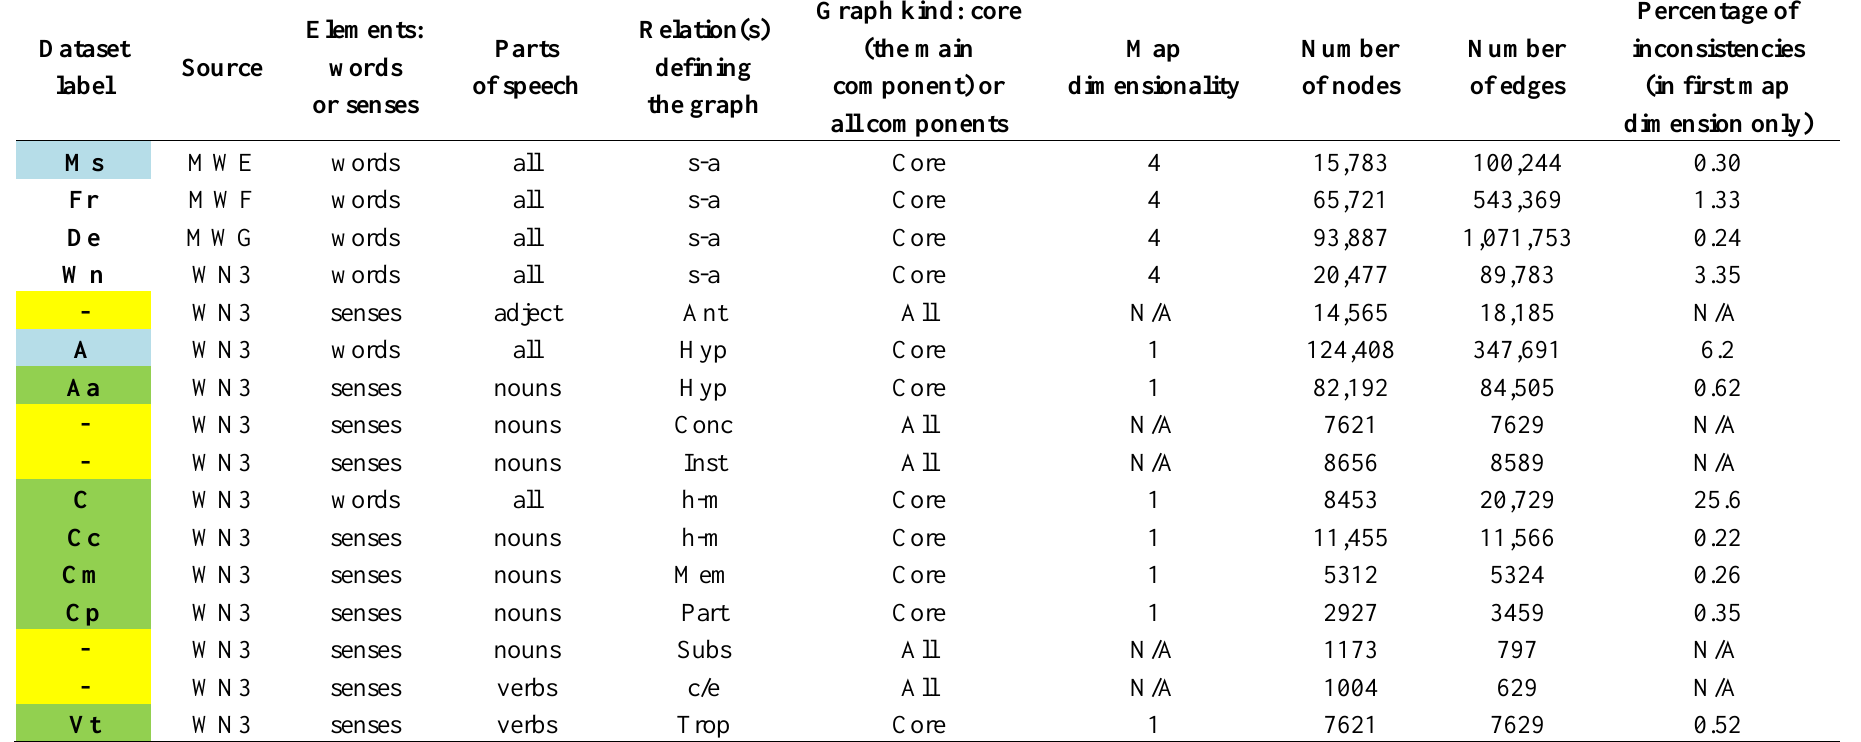
Table 1. Parameters of the weak semantic maps constructed or attempted to date: datasets highlighted in blue correspond to previously published maps that are re-analyzed here; green highlights correspond to new maps introduced in this work; yellow highlights indicate datasets analyzed here but deemed unsuitable for weak semantic mapping; datasets without color highlights are previously published maps that are not re-analyzed here (besides Table 2), but are included for the sake of comprehensiveness. Source